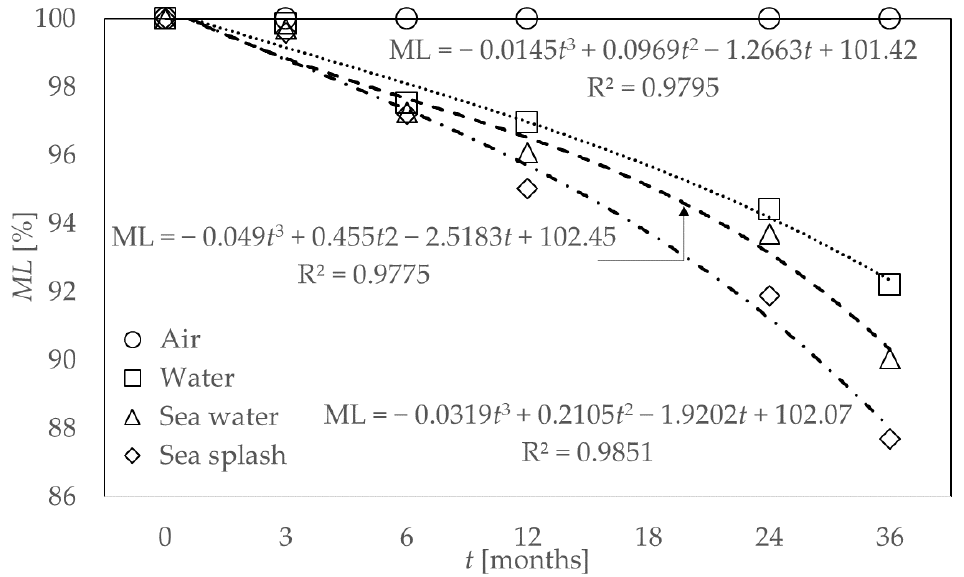
Figure 3. Average percentage of mass loss ( ML ) for AH36 steel specimens exposed over time ( t ) to air, water, seawater, and sea splash for 3, 6, 12, 24, and 36 months. Average corrosion rate CR is calculated according to Equation (2) [39] and given in Figure 4: KW CR = ATD where constant K = 2.4 × 10 6 · D , material density D = 7.8 kg/cm 3 , W = measured mass loss [g], A = specimen area [cm 2 ], T = time of exposure [h]. Corrosion rate describes the